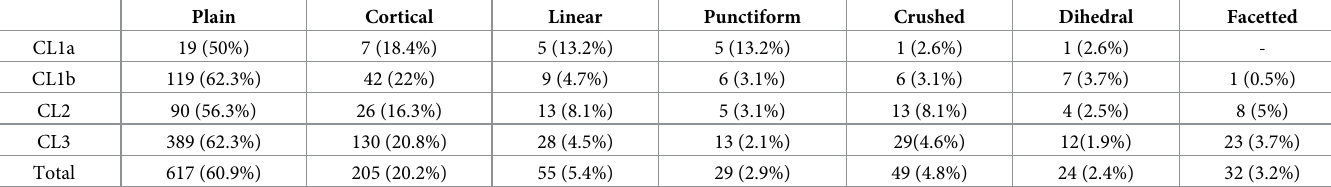
Table 5. The frequency of platform.